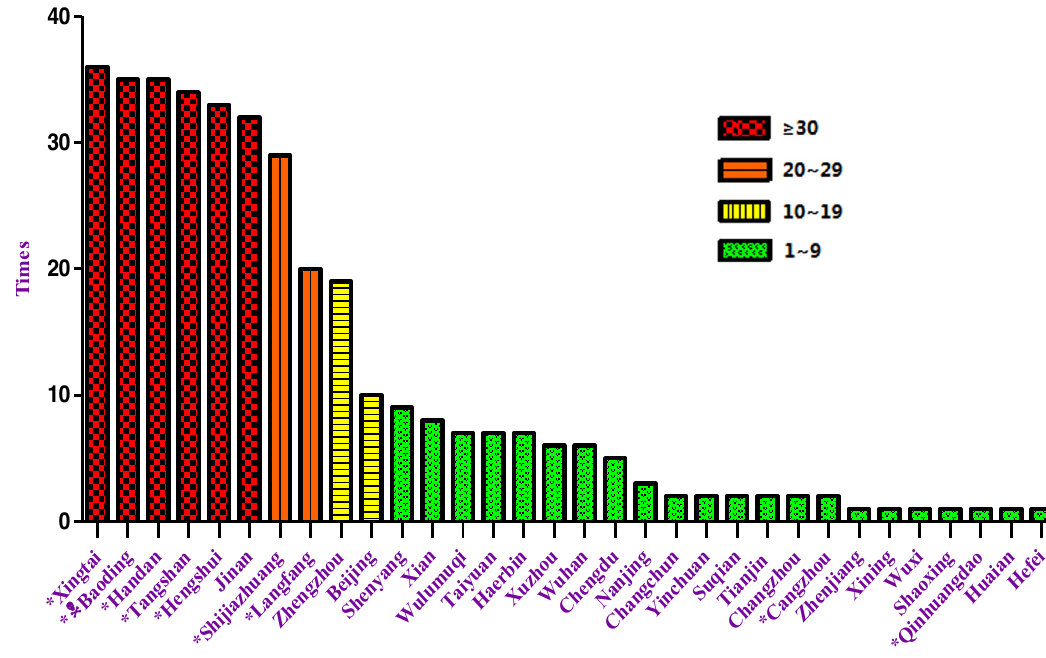
Figure 2: Frequency chart of the 10 most seriously polluted cities according to the ranking of Ambient Air Comprehensive Pollution Index ( 2013.10 – 2016.10 ) . According to the ranking of Ambient Air Comprehensive Pollution Index of 74 major cities in China from October 2013 to October 2016, issued by the Ministry of Ecological Environment of the People ’ s Republic of China, 10 most seriously polluted cities were counted for 3 years ( 36 months ) . Totally, 32 cities have been ranked in most seriously polluted cities during 36 months. In these 32 cities, nine cities are a ffi liated with Hebei, accounting for nearly 30%. Baoding entered 35 times in the chart of most seriously polluted cities, ranking No. 2. *The city belonging to